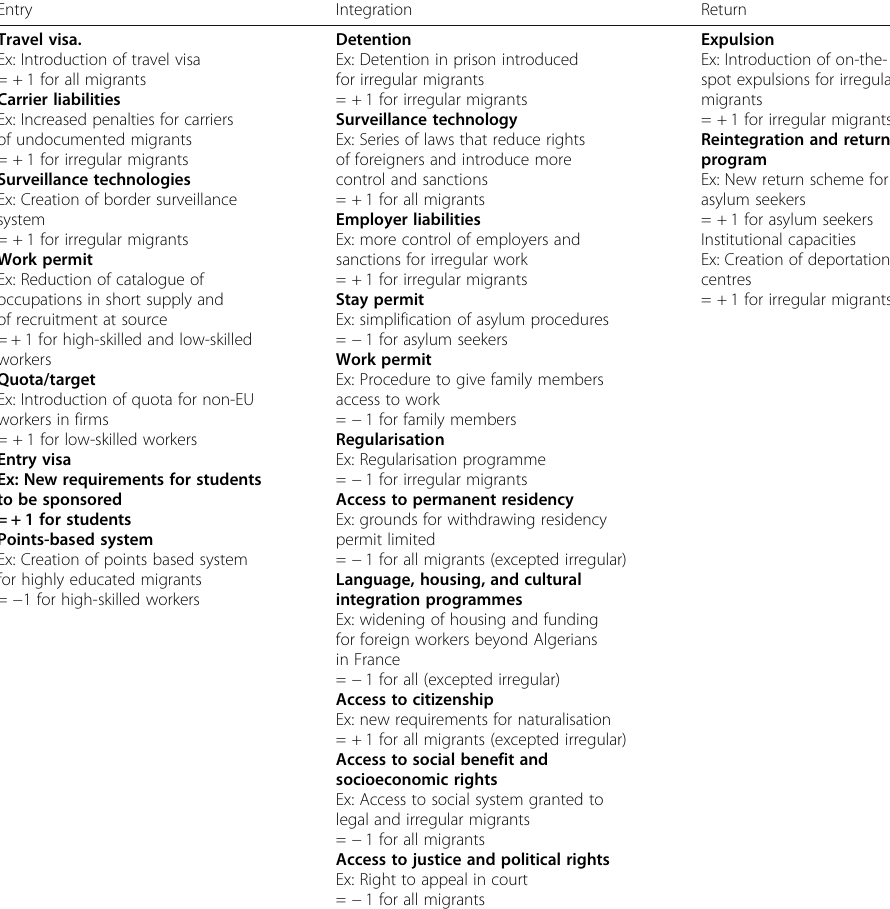
Table 4 Codification examples of policies regulating the entry, integration, and return of migrants